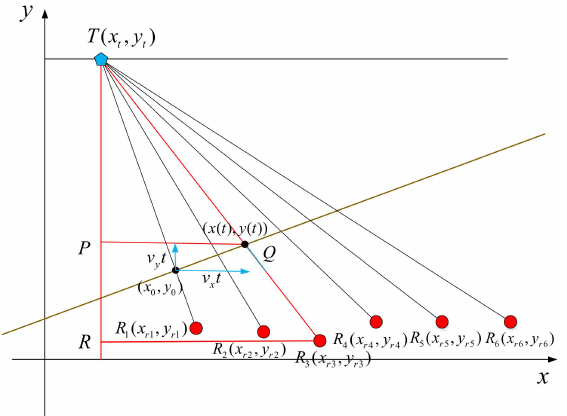
Figure A1. FSR system structure diagram of one-transmitter and